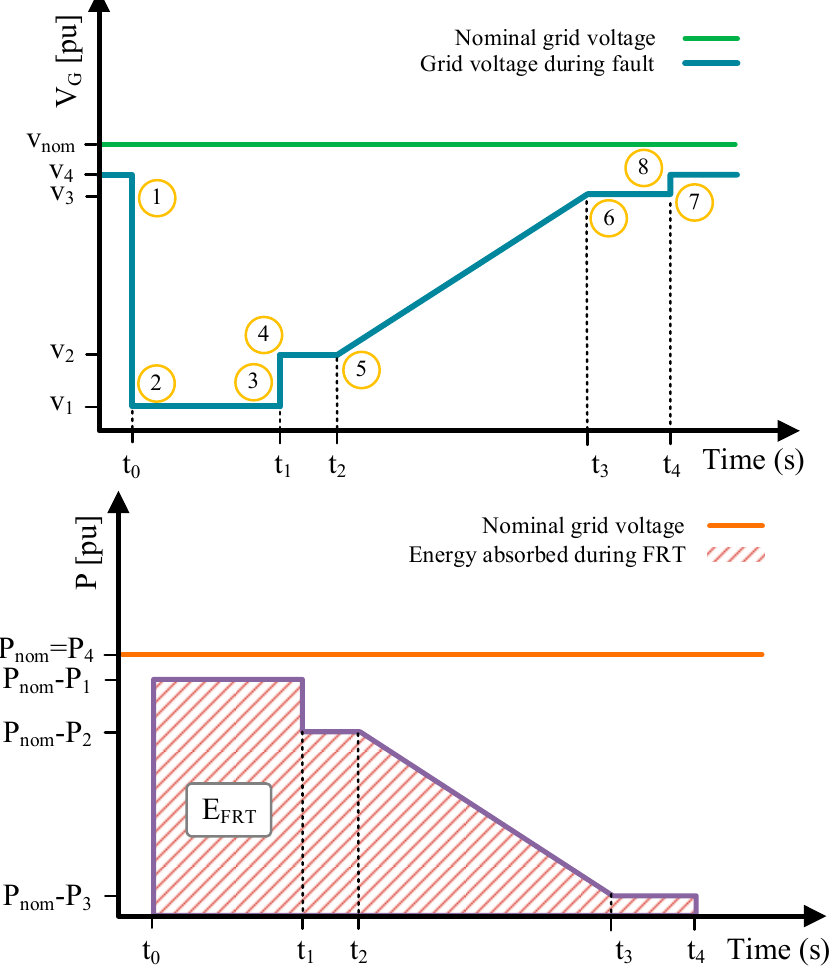
Figure 12. Energy estimation ( bottom ) for supercapacitor sizing based on the generic FRT curve ( top ), [105].